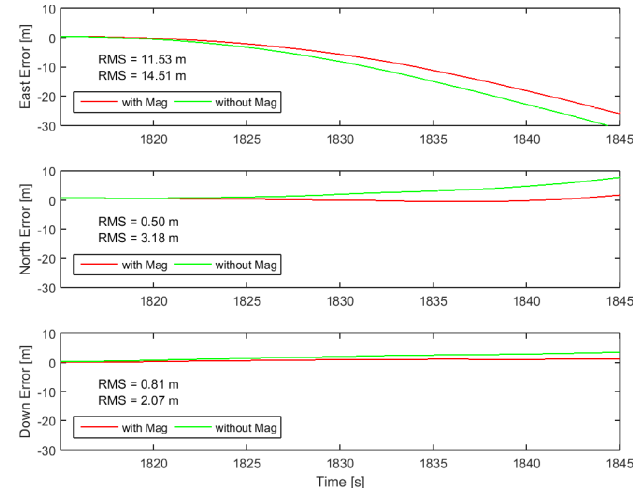
Figure 11. Position error in East, North, and Down during RTK signal outage Figure 12 demonstrates the attitude error between the reference and the INS/RTK integration with magnetometer and without magnetometer during the RTK signal outage period. The roll, pitch, and azimuth RMS errors are 0.19, 0.23, 0.14 m and 0.28, 0.26, 0.14 degree respectively as shown in Table 4. The green line represents the INS/RTK integration without magnetometer, and the INS/RTK integration with magnetometer is presented by the red